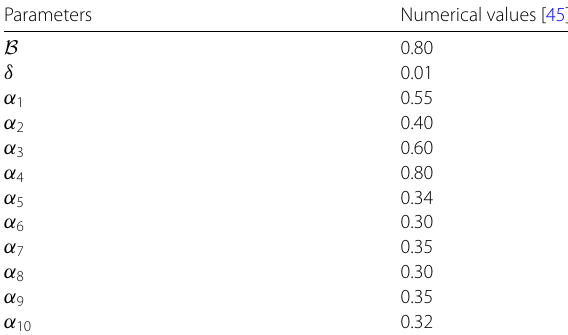
Table 1 The physical interpretation of the parameters and numerical values